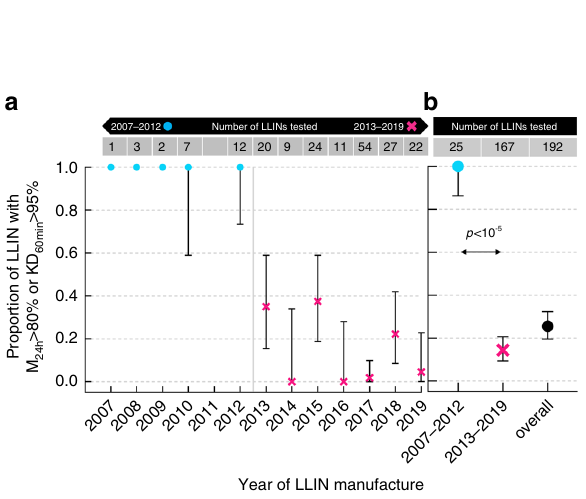
Fig. 2 Proportion of new and unused LLINs with adequate bioef fi cacy by year of manufacture. a Proportion of new and unused LLIN exhibiting ≥ 95% 60 min knockdown (KD ≥ 80% adjusted 24 h mortality 60min ) or (M 24h ) grouped by year of manufacture. b Proportion of LLINs exhibiting ≥ 95% 60 min knockdown (KD ≥ 80% adjusted 24 h mortality 60min ) or (M 24h ) for groups with years of manufacture between 2007 – 2012 (turquois circles) and from 2013 to 2019 (magenta crosses), as well as overall (2007 – 2019, black circle). The table on top of the panels indicates the numbers of individual LLINs tested in each year or group. Data are presented as mean proportions and their exact 95% con fi dence intervals. The p-value between the 2007 – 2012 and 2013 – 2019 groups is the result of a Chi-squared test (2-sided) comparing the proportions in these two groups. The exact z-score of the test is 8.442. Source data for this Figure are provided as a Source Data fi